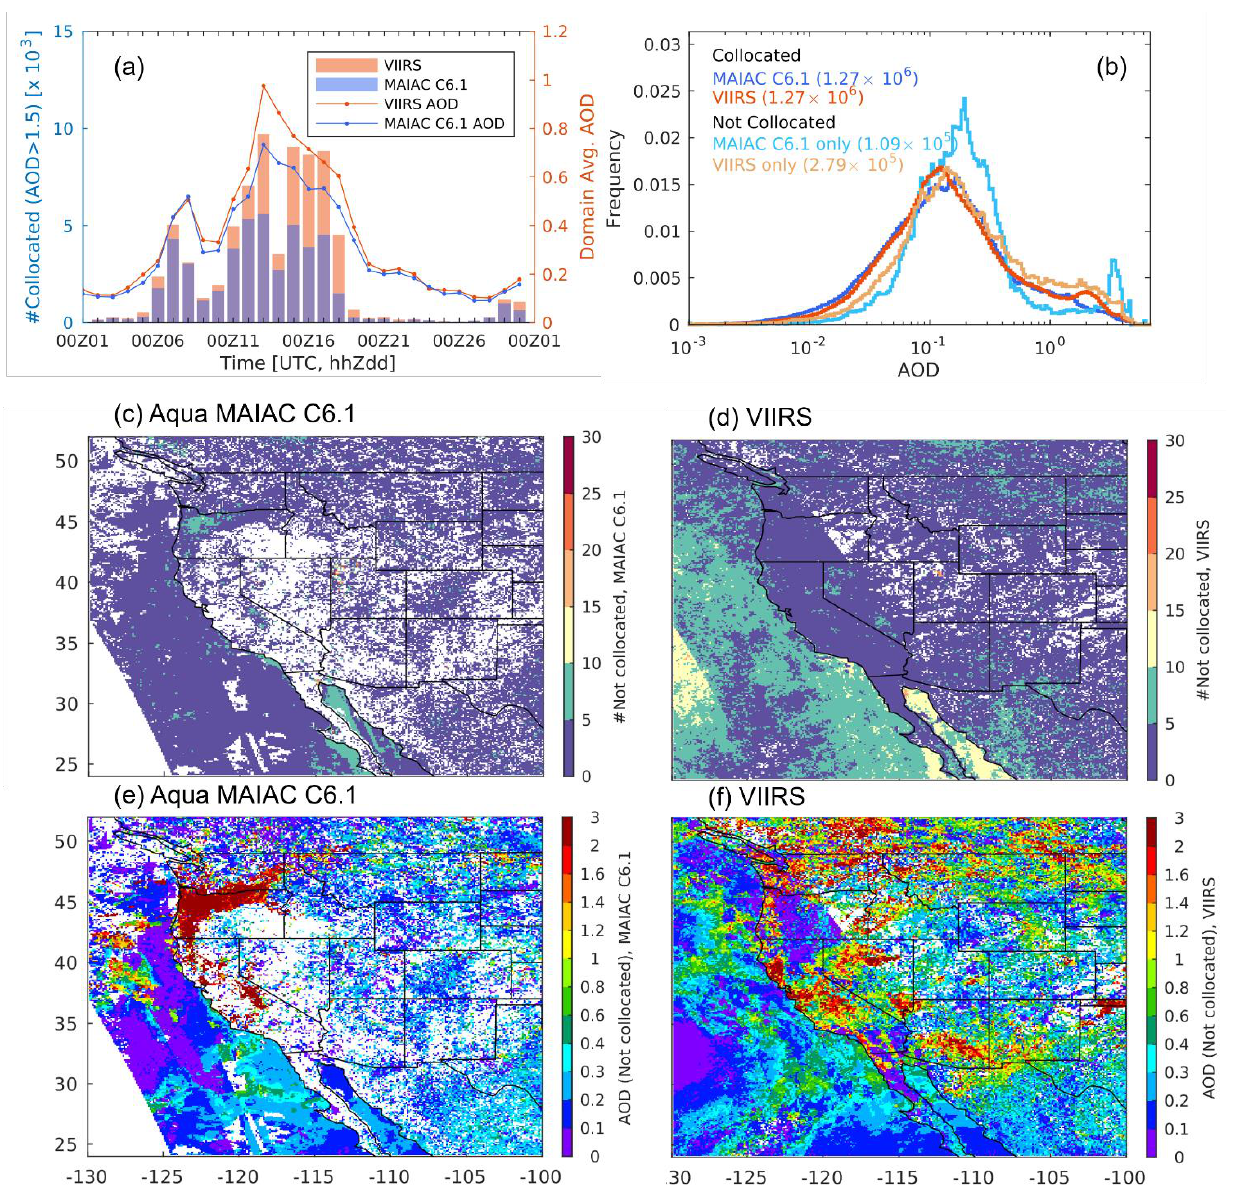
Figure 5. ( a ) Daily time series of number of grid cells with AOD > 1.5 (left y-axis, bars) and domain average AOD (right y-axis, dotted lines) for collocated gridded data for Aqua MODIS MAIAC C6.1 and VIIRS; ( b ) Frequency distribution of the AOD values in bins in logarithmic scale for collocated data from VIIRS, and Aqua MODIS MAIAC C6.1, and the not collocated data individually; ( c , d ) Map distribution of the number of days with non-collocated data on the 0.1 ◦ grid in September 2020 and ( e , f ) the monthly average AOD across those non-collocated grid cells for Aqua MODIS MAIAC C6.1 and VIIRS, respectively.